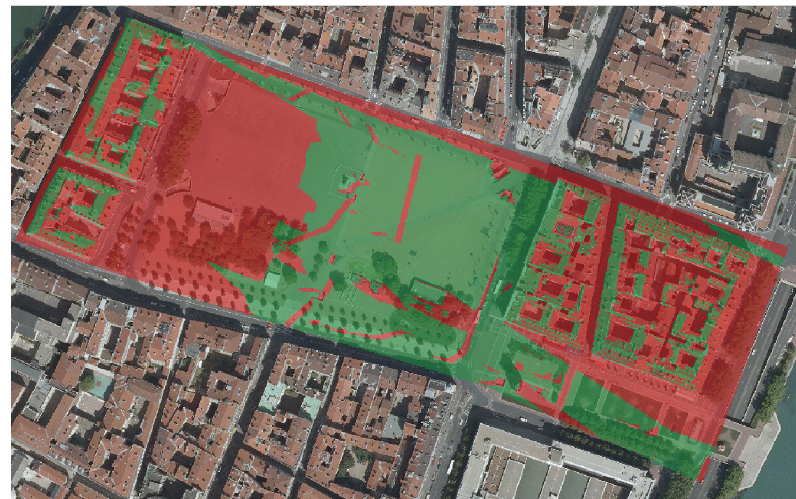
Figure 16. Raster analysis results regarding the visibility of the Fourvière Basilica (Bellecour Square). Green pixels indicate that the Basilica is seen, and red pixels that it is not seen. The results are displayed on an aerial image of the square; hence transparency is used.